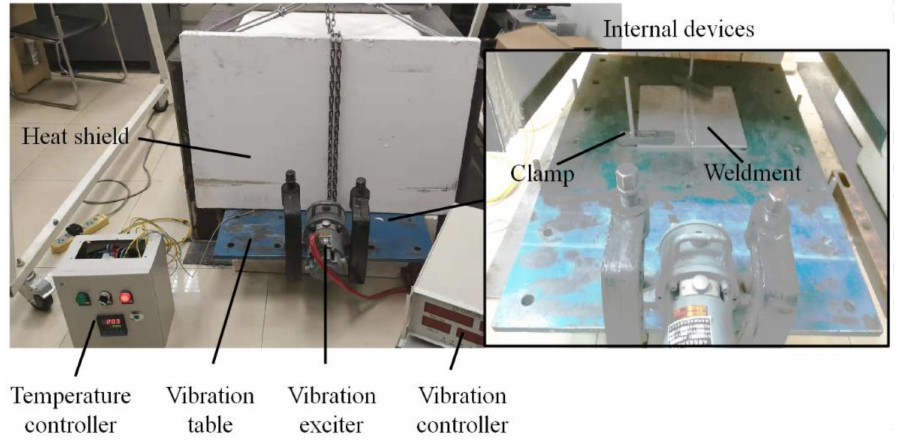
Figure 3. Vibration system and Thermal